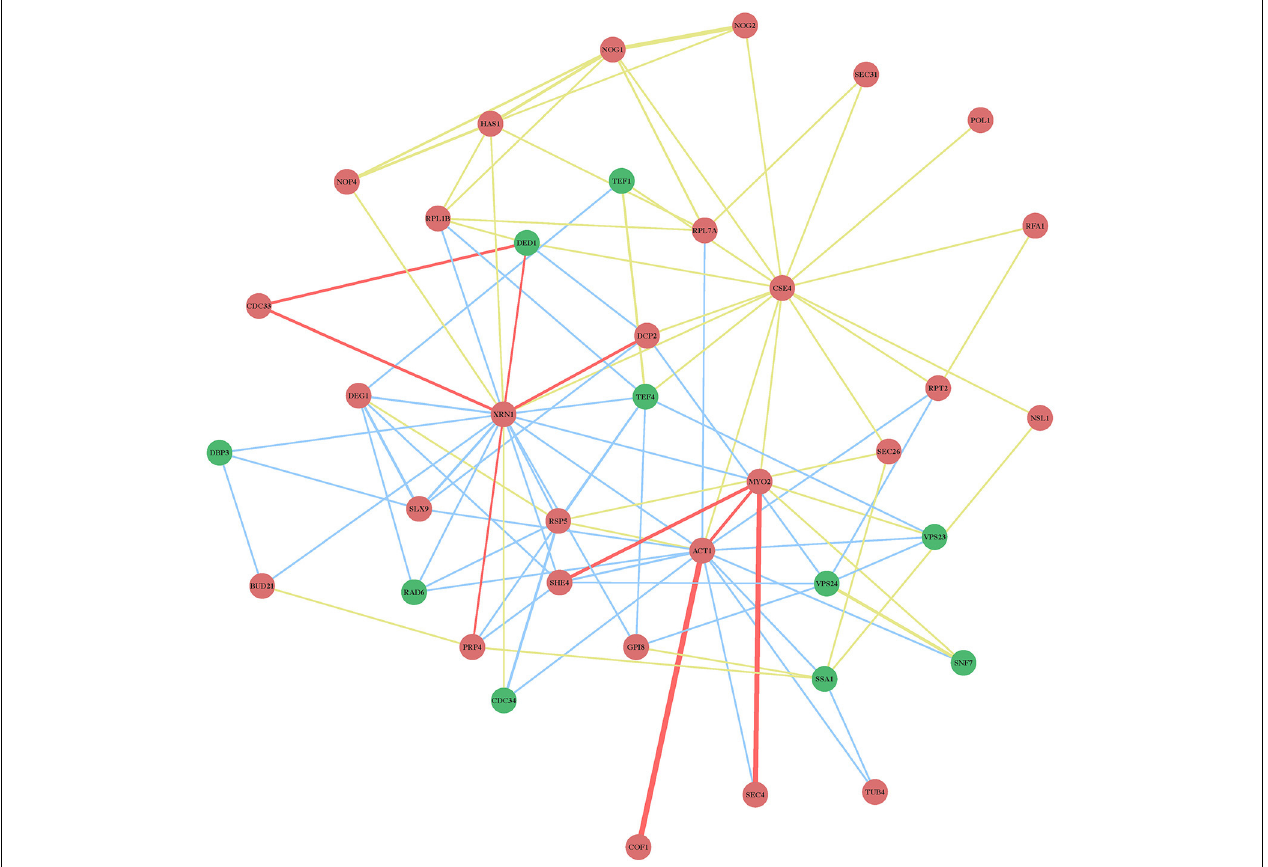
FIGURE 3 | Physical and genetic protein interaction networks including XRN1, ACT1, and CSE4 CIRFs. See further details in the legend to Figure 2